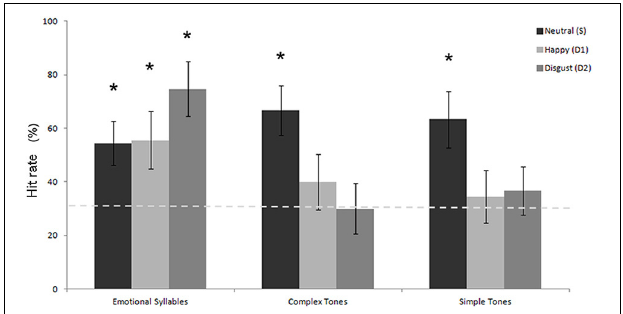
FIGURE 2 | Hit rate in the emotional categorization task. The emotional syllables exhibited more favorable performance than did the complex and simple tones. Only the emotional syllables attained above-chance hit rates for each emotion. The asterisk ( ∗ p < 0 . 05) indicates that the hit rate is statistically higher than the chance level (dashed